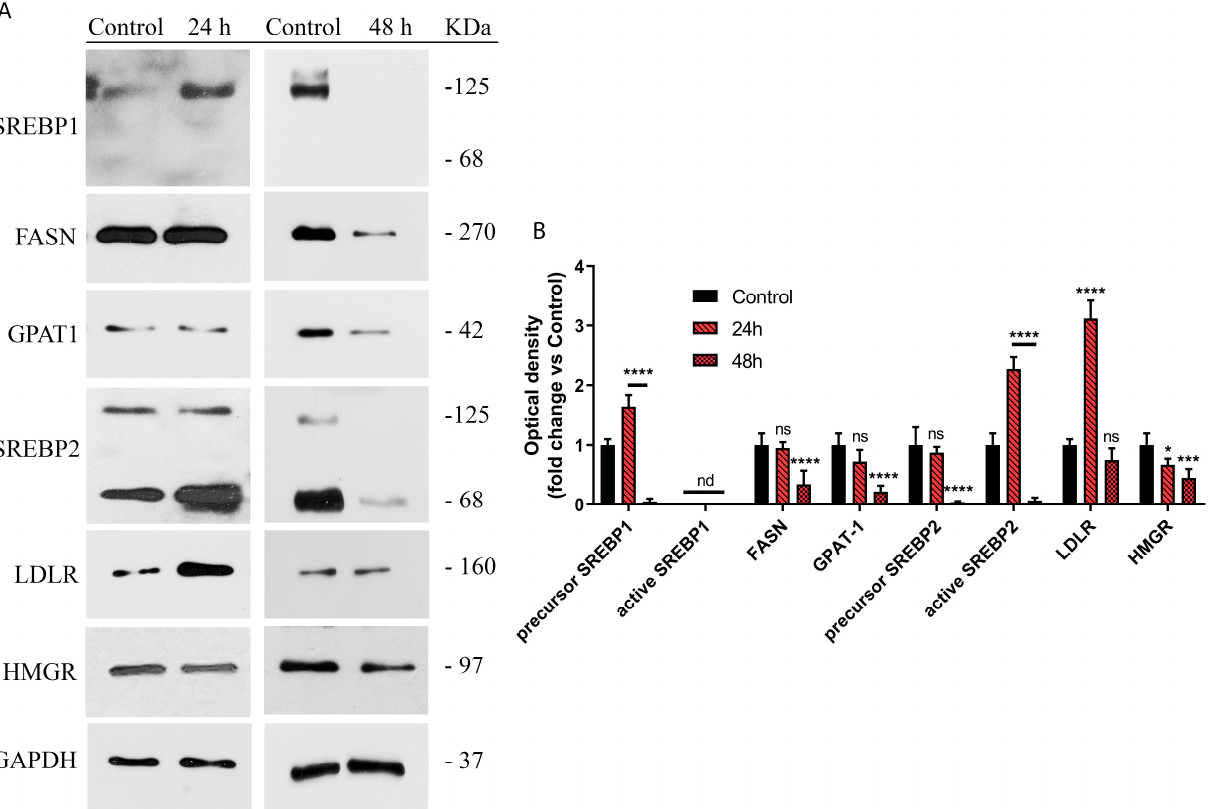
Figure 5. Effects of picrocrocin on protein expression of enzymes related to lipid metabolism. ( A ) Immunoblot analysis of the main proteins involved in lipid homeostasis after treatment of HepG2 cells for 24 and 48 h with PEF from our saffron extract. ( B ) Quantification of protein expression levels by densitometry. Values represent mean ± SD of three independent experiments. * p value < 0.05; *** p value < 0.001; **** p value < 0.0001; ns: non-significant; nd: not detectable.